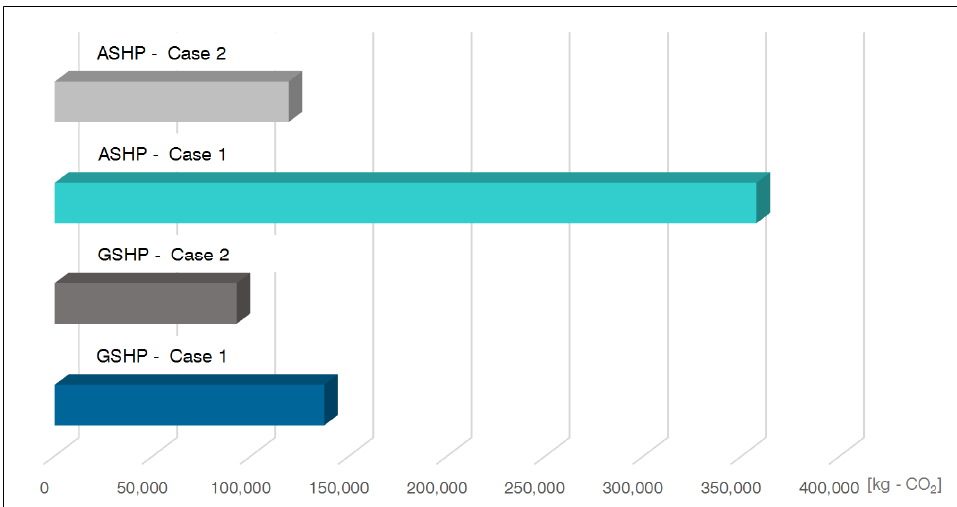
Figure 9. CO 2 emissions accumulated during the 30 years of useful life of each assumption. *Calculations are based on an emission factor of 0.331 kg CO 2 /kWh electricity [45].